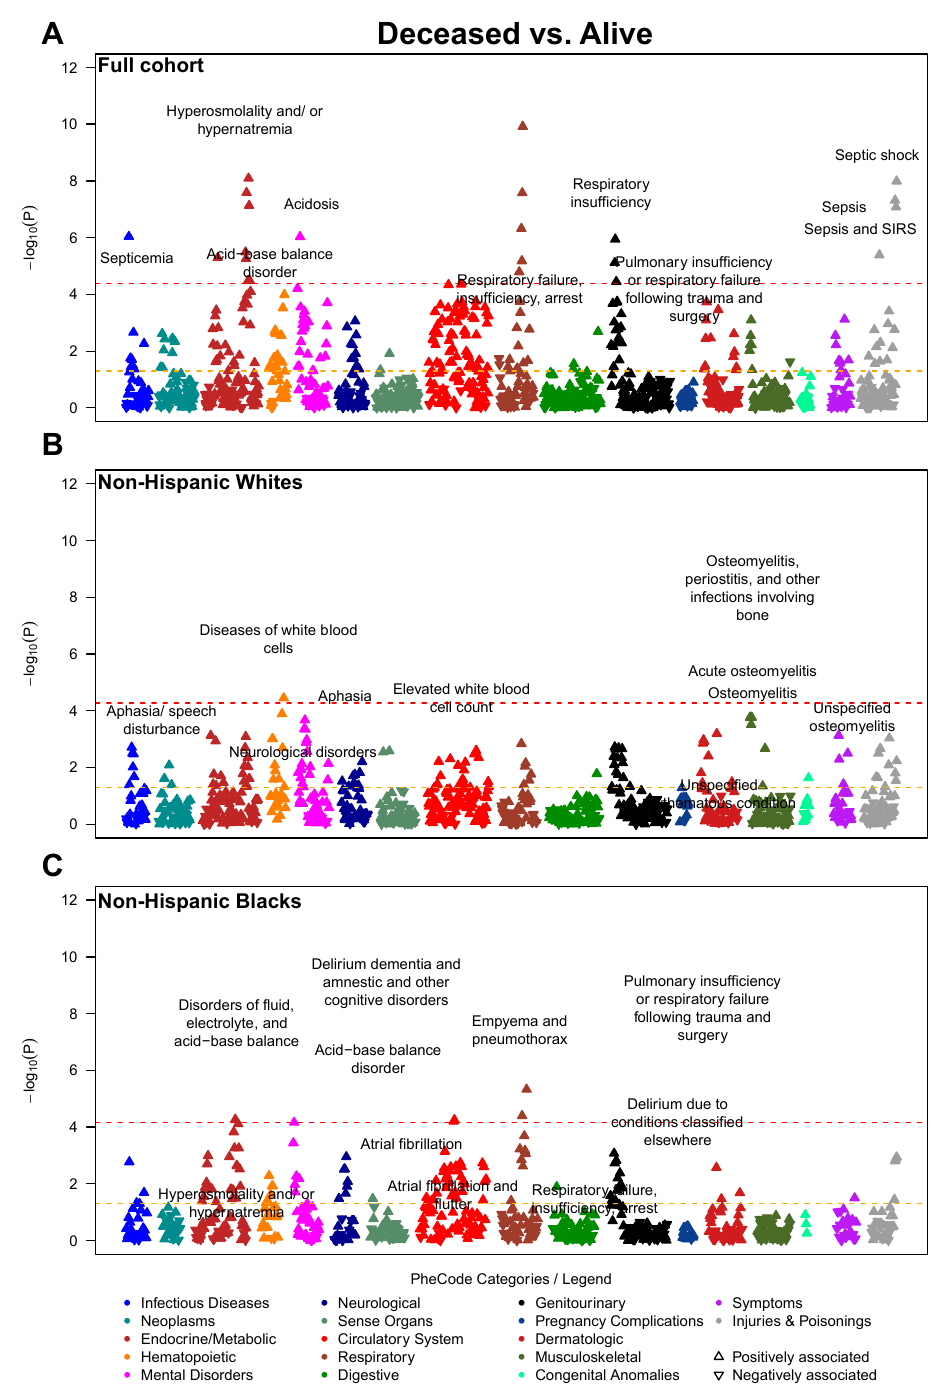
Figure 3. Manhattan plot showing the phenome-wide association between disease conditions and prognostic outcomes for COVID-19. Models are adjusted for age, sex, race (full cohort only), and three census tract-level socioeconomic indicators: proportion with less than high school education, proportion unemployed, and proportion with annual income below the federal poverty level. The x -axis are individual disease codes, color-coded by their corresponding disease category as described in the shared legend. The y -axis represents the − log 10 transformed p -value of the association. The dashed, horizontal lines represent the p = 0.05 (in orange) and the Bonferroni corrected p -value (0.05/number of tests; in red). Each point is represented by either an upward triangle indicating a positive association or a downward triangle indicating a negative association. ( A ): Full cohort, ( B ): Restricted to Whites, ( C ): Restricted to Blacks